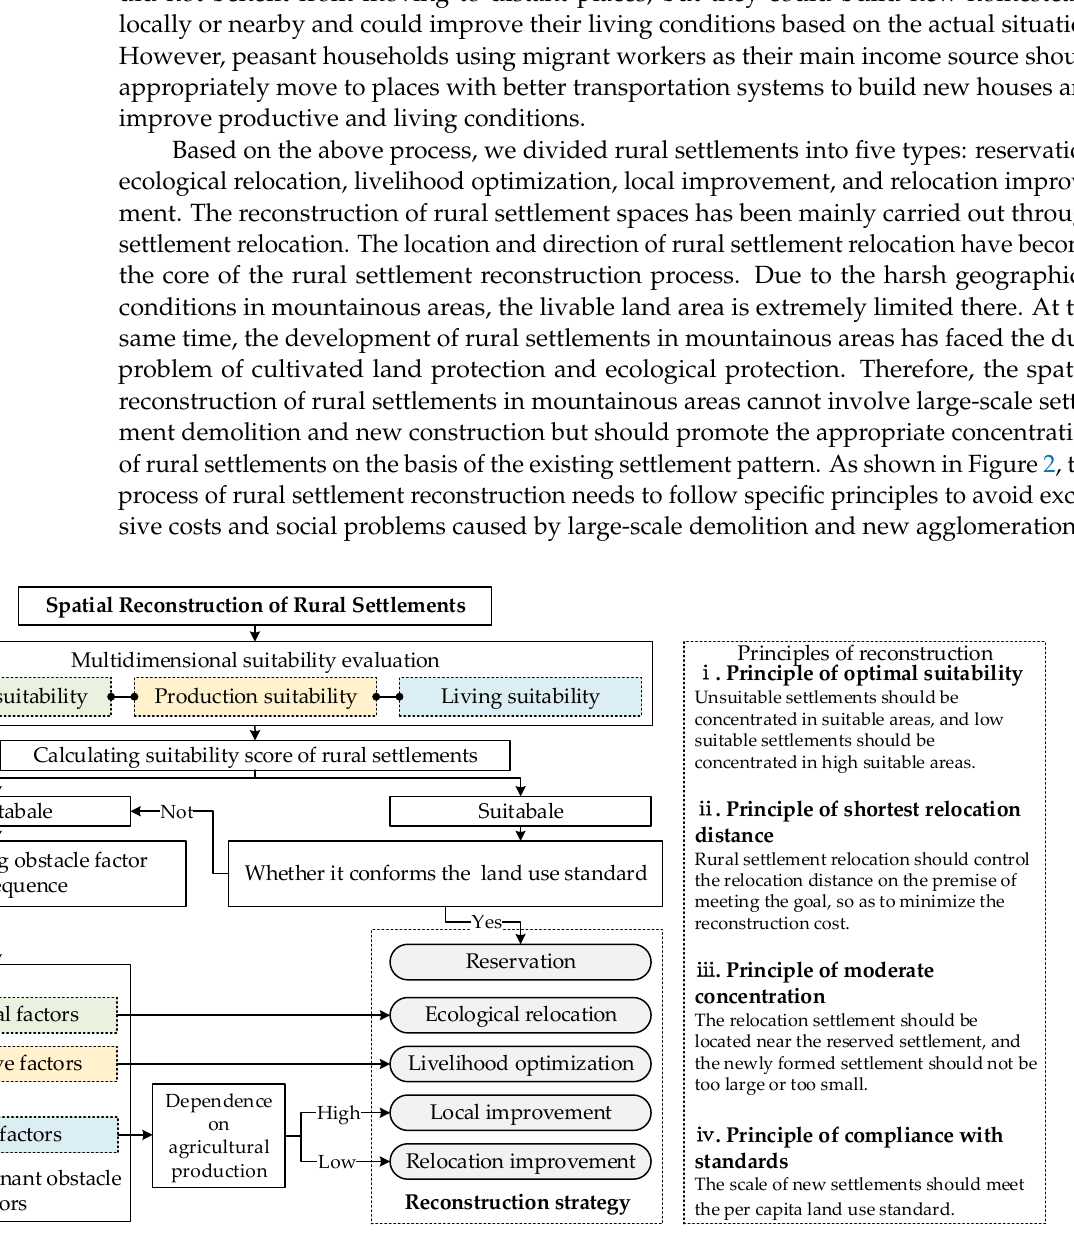
Figure 2. Framework of the reconstruction of rural settlements.